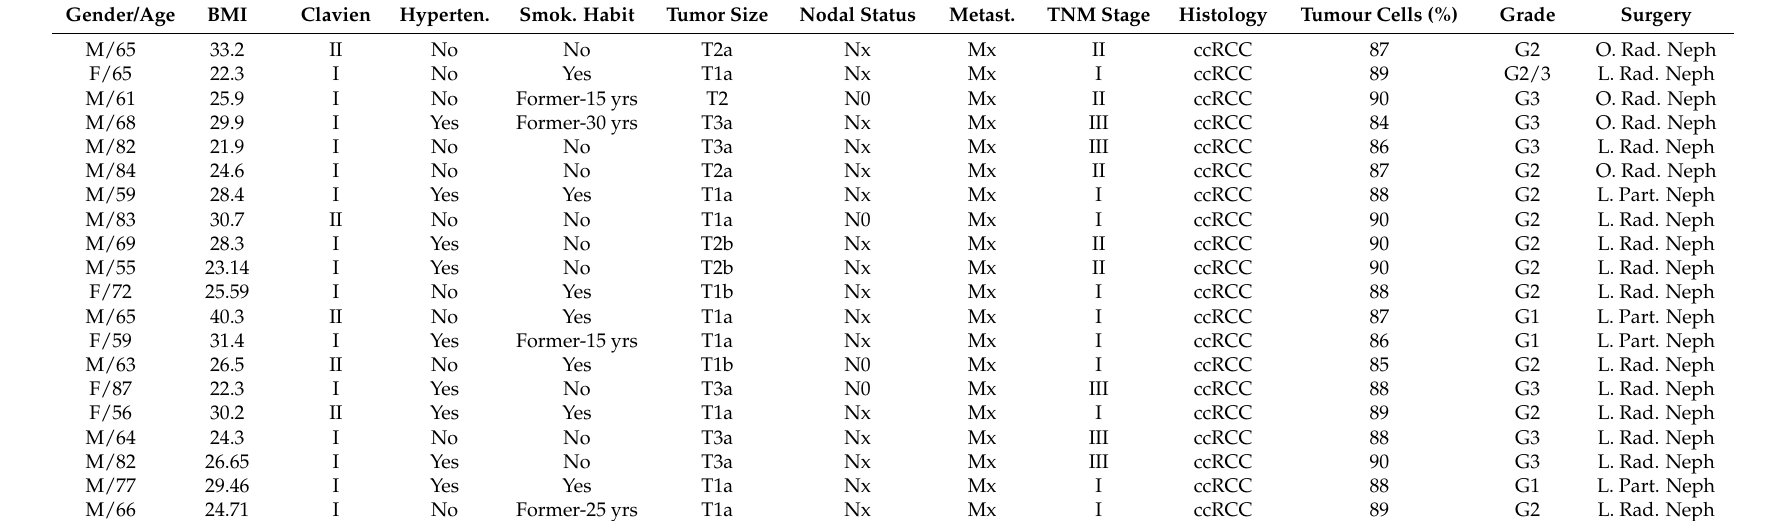
Table 1. Clinical characteristics of patients with clear cell renal cell carcinoma